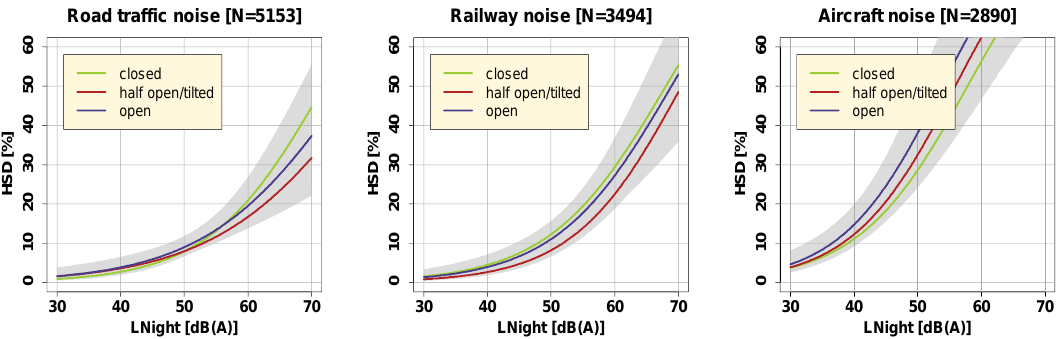
Figure 5. Exposure-response relationships for road traffic (left), railway (middle), and aircraft noise (right), for different habitual bedroom window positions (closed, half-open/tilted, open), including 95% (overlapping) confidence intervals (shaded areas). Curves are based on the adjusted model in the full sample with covariates centered on the mean.